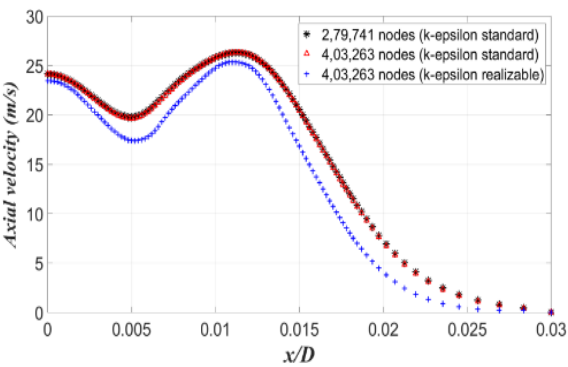
Figure 4. Grid sensitivity test.